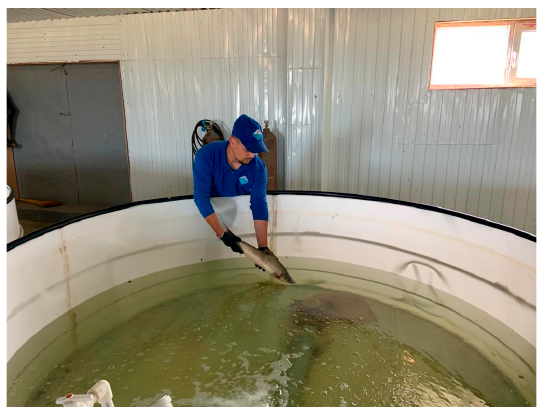
Figure 4. Seeding of selected Aral barbels for domestication in basin conditions.